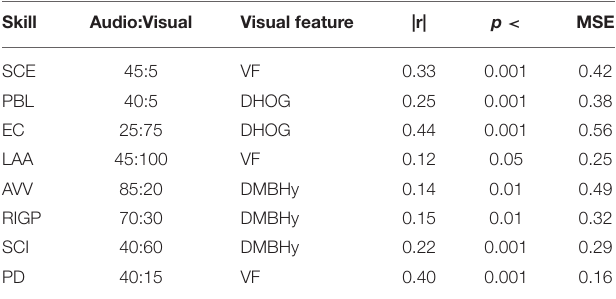
TABLE 7 | Best SVM regression model results for each presentation delivery skill (such as SCE, PBL, etc.) using Fusion of Audio-Visual features.